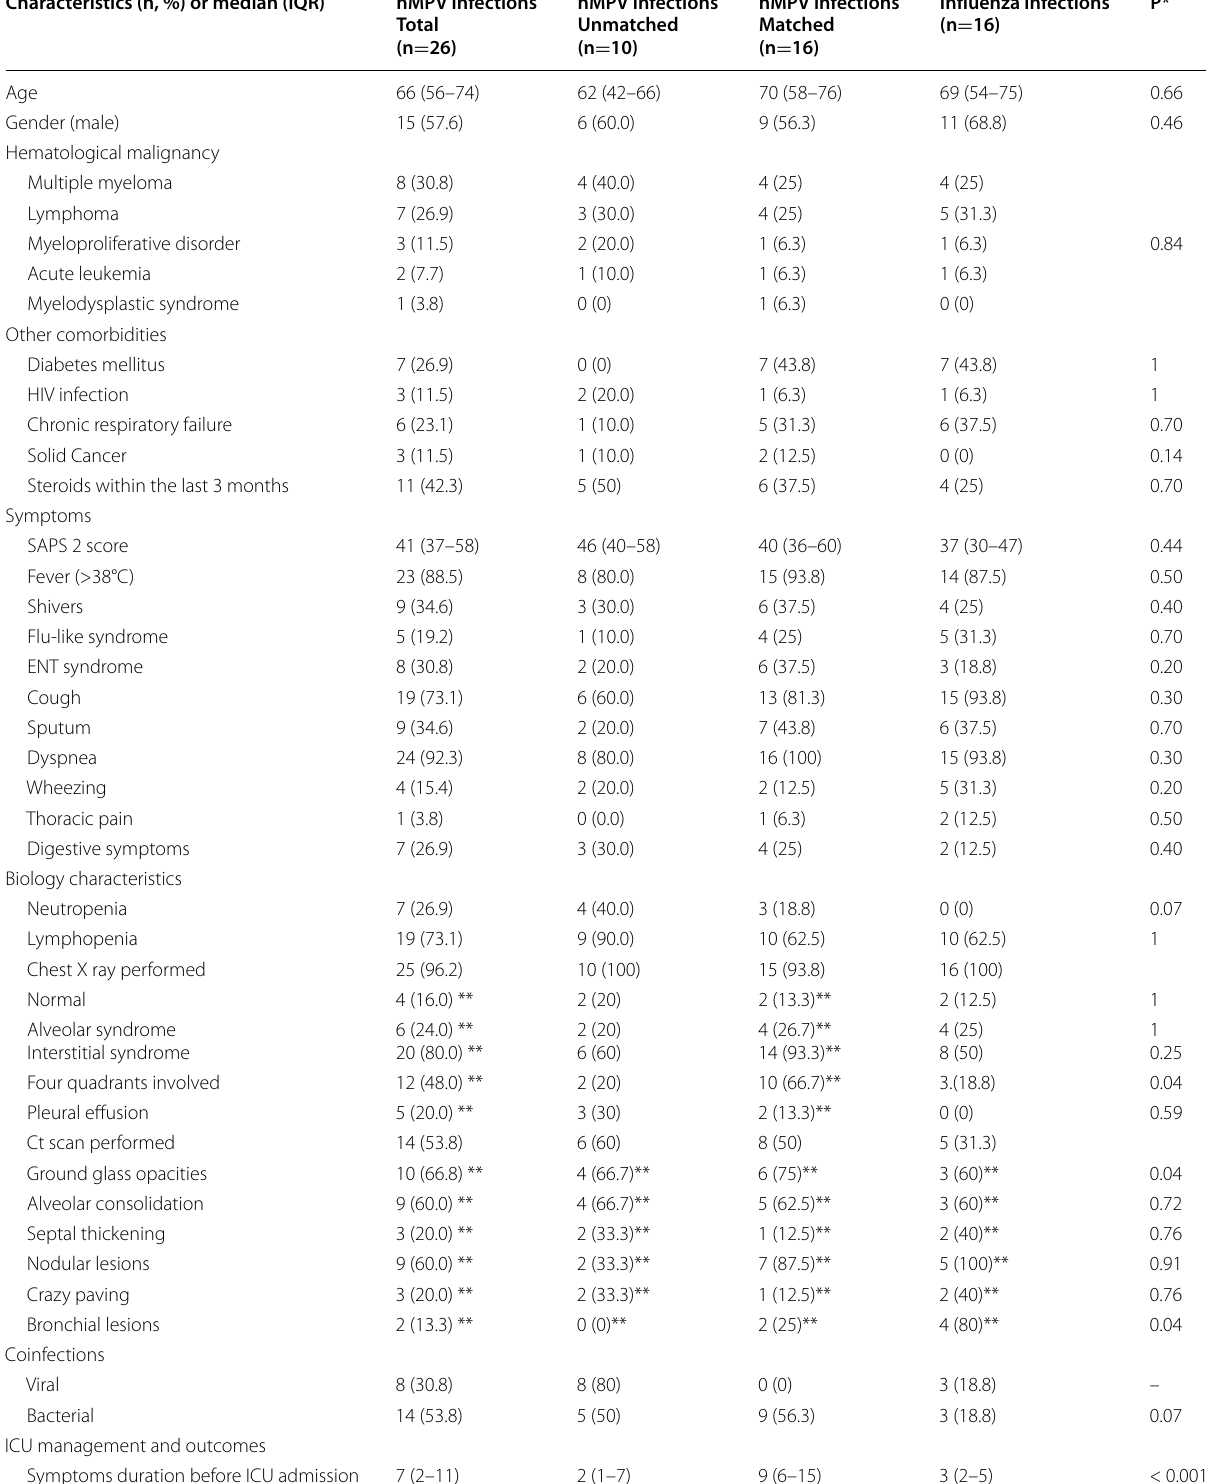
Table 1 Clinical, biological, and radiological characteristics of patients admitted to ICU for hMPV infection and results of the univariate analysis comparing influenza and hMPV infected matched patients Characteristics (n, %) or median